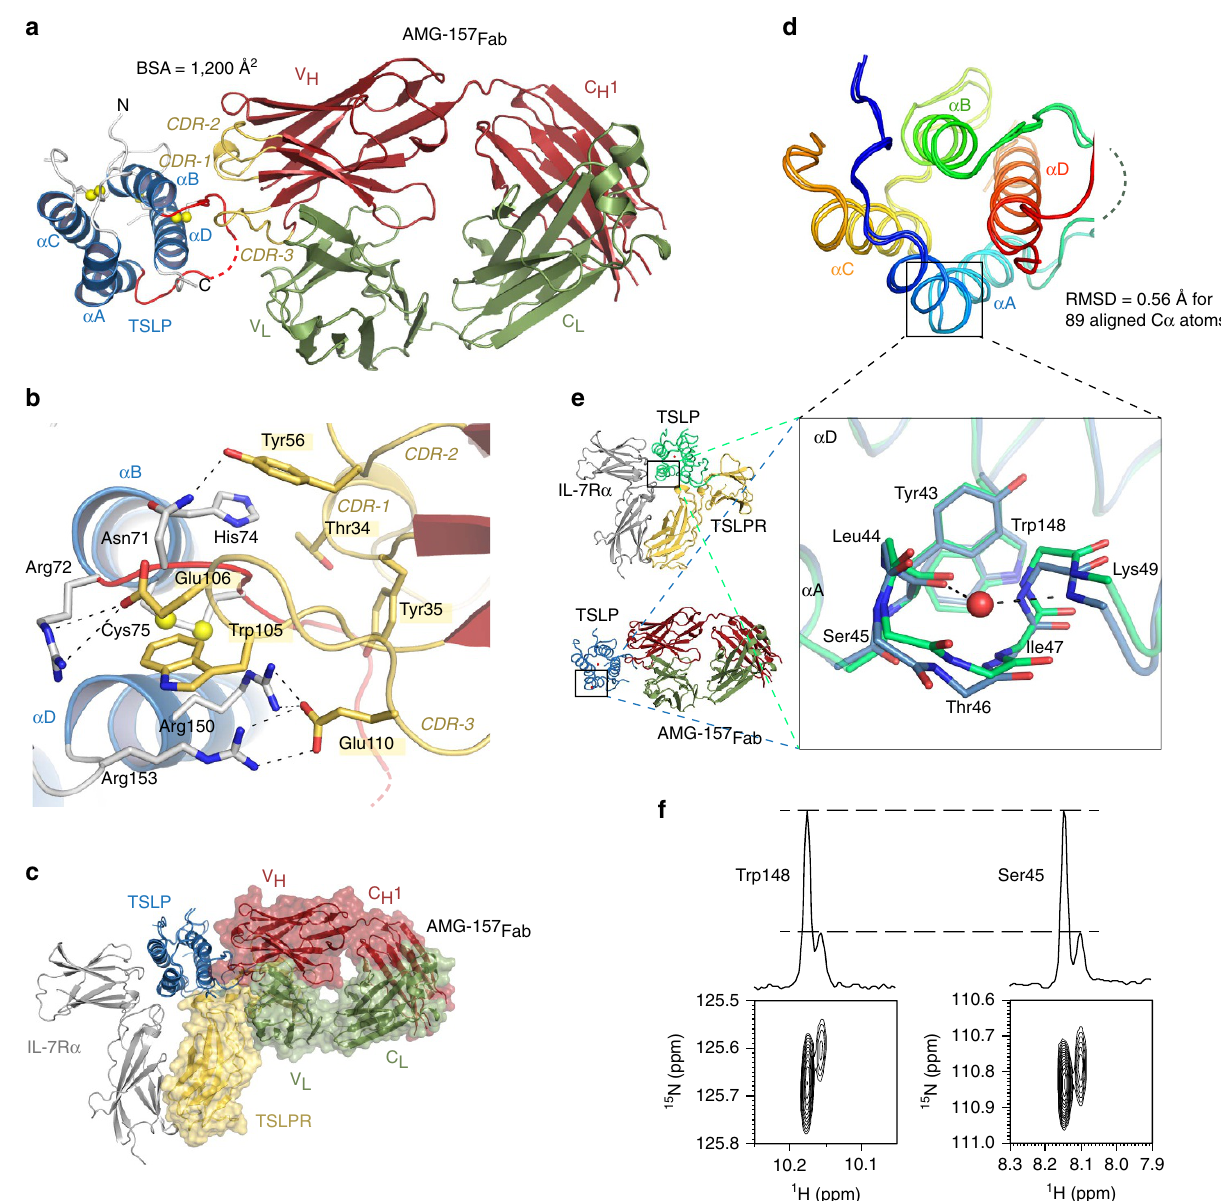
Figure 7 | Structure of the TSLP:AMG-157 Fab complex and insights into TSLP antagonism and plasticity. ( a ) Cartoon representation of the determined X-ray structure for AMG-157 Fab -fragment in complex with TSLP. TSLP helices ( a A– a D) are coloured in blue and TSLP loop regions in white, except the AB loop (red). The red dashed line represents to two disordered residues in the TSLP AB loop. N-and C-termini are indicated. The V H -C H 1 and V L -C L fragments of AMG-157 Fab are coloured in maroon and green, respectively. V H CDR-loops are labelled and coloured yellow. BSA: buried surface area. ( b ) Detail of the TSLP:AMG-157 Fab interface. Selected interface residues are labelled and shown as sticks. Dashed lines represent salt bridges and hydrogen bonds. ( c ) Superposition of the TSLP:TSLPR:IL-7R a and TSLP:AMG-157 Fab complexes based on the structural alignment of the two TSLP structures. TSLPR (yellow) and the light chain (green) and heavy chain (maroon) of the AMG-157 Fab fragment are displayed in surface mode. ( d ) Aligned human TSLP X-ray structures are shown as cartoons and are coloured according to a rainbow scheme with the N-terminus in blue and the C-terminus in red. ( e ) Structural comparison of the main chain conformation of the p -helical turn in TSLP helix A in both determined TSLP structures. The water molecule in the p -helical turn of helix a A of TSLP complex by AMG-157 Fab (blue) is shown as a red sphere. ( f ) Zoomed regions of the 1 H, 15 N HSQC-spectrum for TSLP D 127–131 at 900MHz show the N e –H e Trp148 side chain (left) and Ser45 main chain amide (right) resonances. The projection of these regions on top of each panel shows that both minor forms adopt an identical